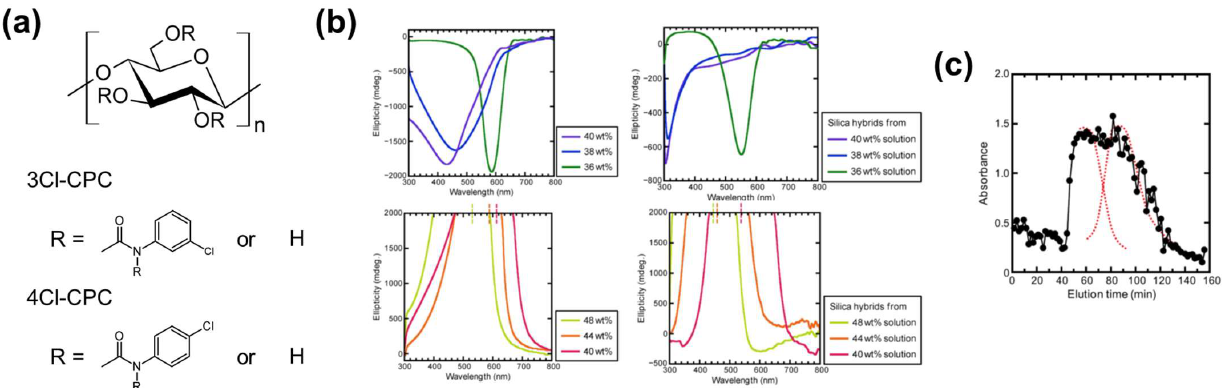
Figure 10. ( a ) Chemical structures of cellulose, 3-chlorophenylcarbamate (3Cl-CPC), and 4-chlorophenylcarbamate (4Cl- CPC). ( b ) Circular dichroism spectra of 3Cl-CPC/3-aminopropyltrimethoxysilane (left) and 4Cl-CPC/tetramethyl orthosil- icate/dimethylformamide/dichloroacetic acid (right) cholesteric liquid crystal solutions with various cellulosic concentra- tions. ( c ) Chromatographic profile for racemic trans -stilbene oxide using an open column filled with a 4Cl-CPC–silica hybrid ( a – c ) were reproduced from [79] by permission of Elsevier).